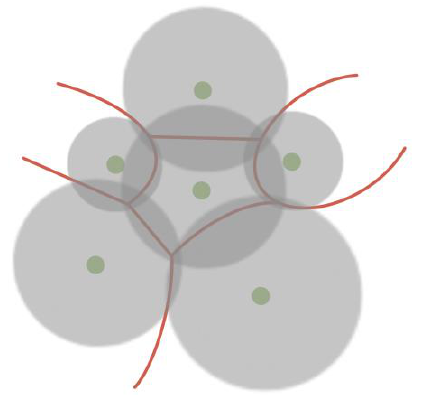
Figure 18. Voronoi diagram in which the distance to the separating edge is related to the weight of the centroid. This approach makes it possible to obtain curved edges of Voronoi cells.